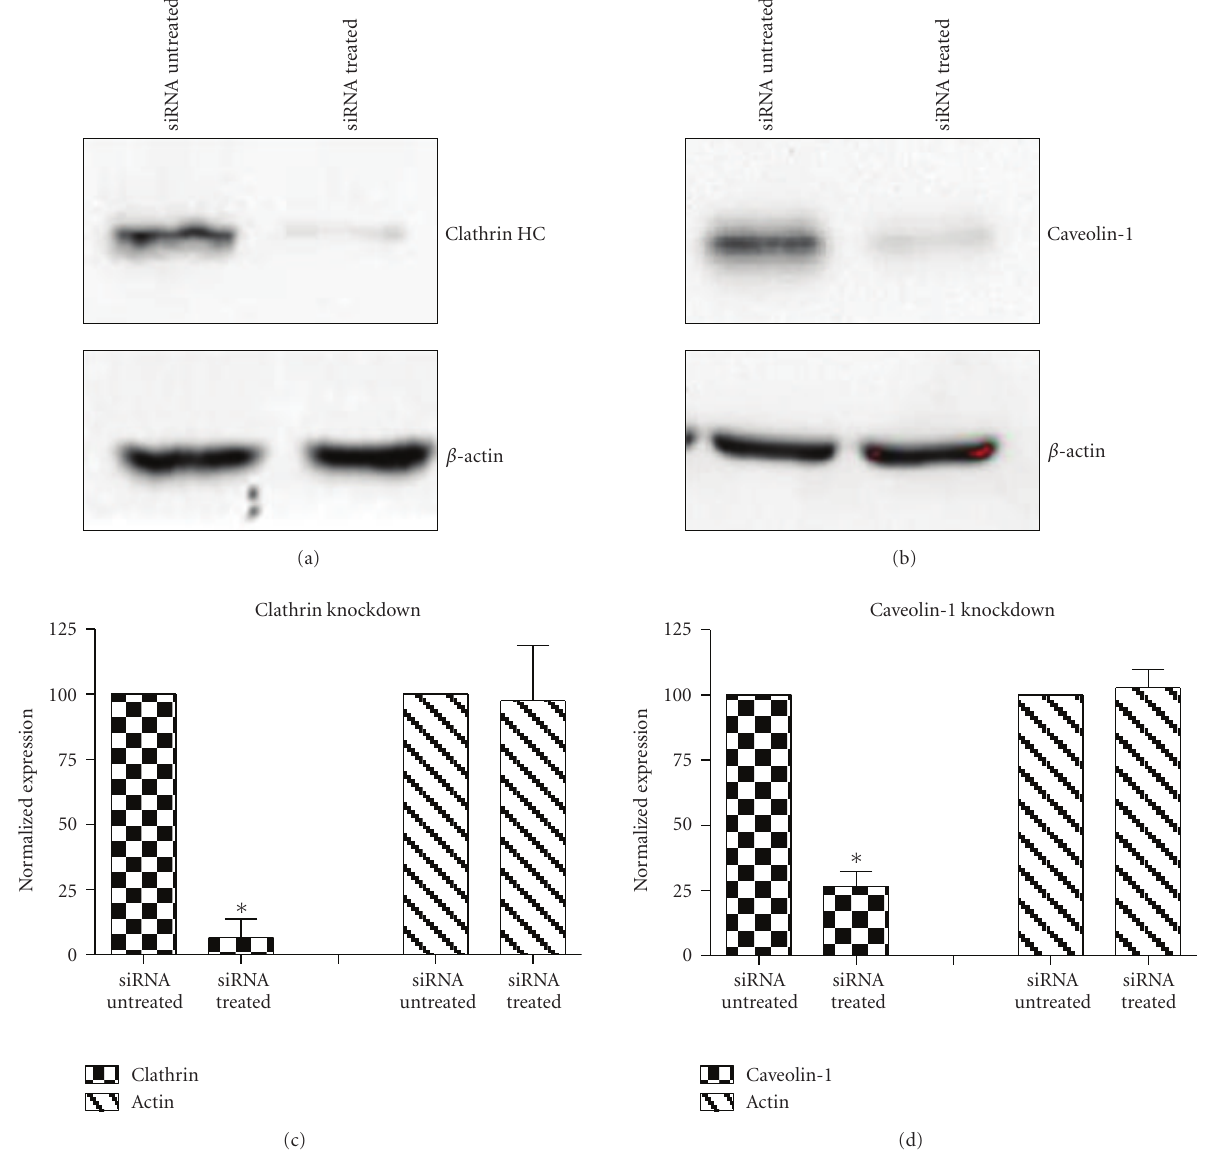
Figure 10: Western blot analysis of clathrin HC and caveolin-1 protein after siRNA treatment. A549 cells were treated with siRNA of clathrin HC or caveolin-1 protein for 3 days, and then cells were lysed for Western blot analysis. (a) Clathrin HC protein expression in A549 cells. (b) Caveolin-1 protein expression in A549 cells. β -actin was used as the internal control. (c) and (d) Quantification analysis of the Western blots. Intensity is normalized to the siRNA untreated group. Values are mean ± SD from three independent experiments ( ∗ P (cid:5) s < . 01 versus